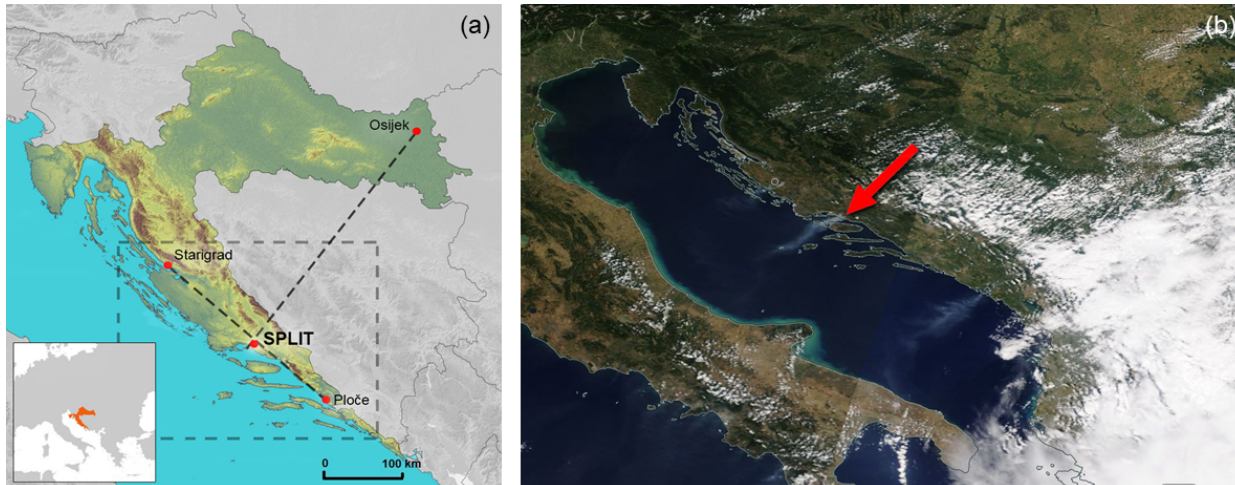
Figure 1. (a) Location of the Split wildfire in Croatia with positions of vertical cross-sections (dashed lines) and location of the inner nested domain used in the ALADIN model simulation (dashed rectangle) and (b) Terra satellite MODIS image on 17 July 2017 showing active fire areas along the Adriatic Sea coast (https://worldview.earthdata.nasa.gov, last access: 18 August